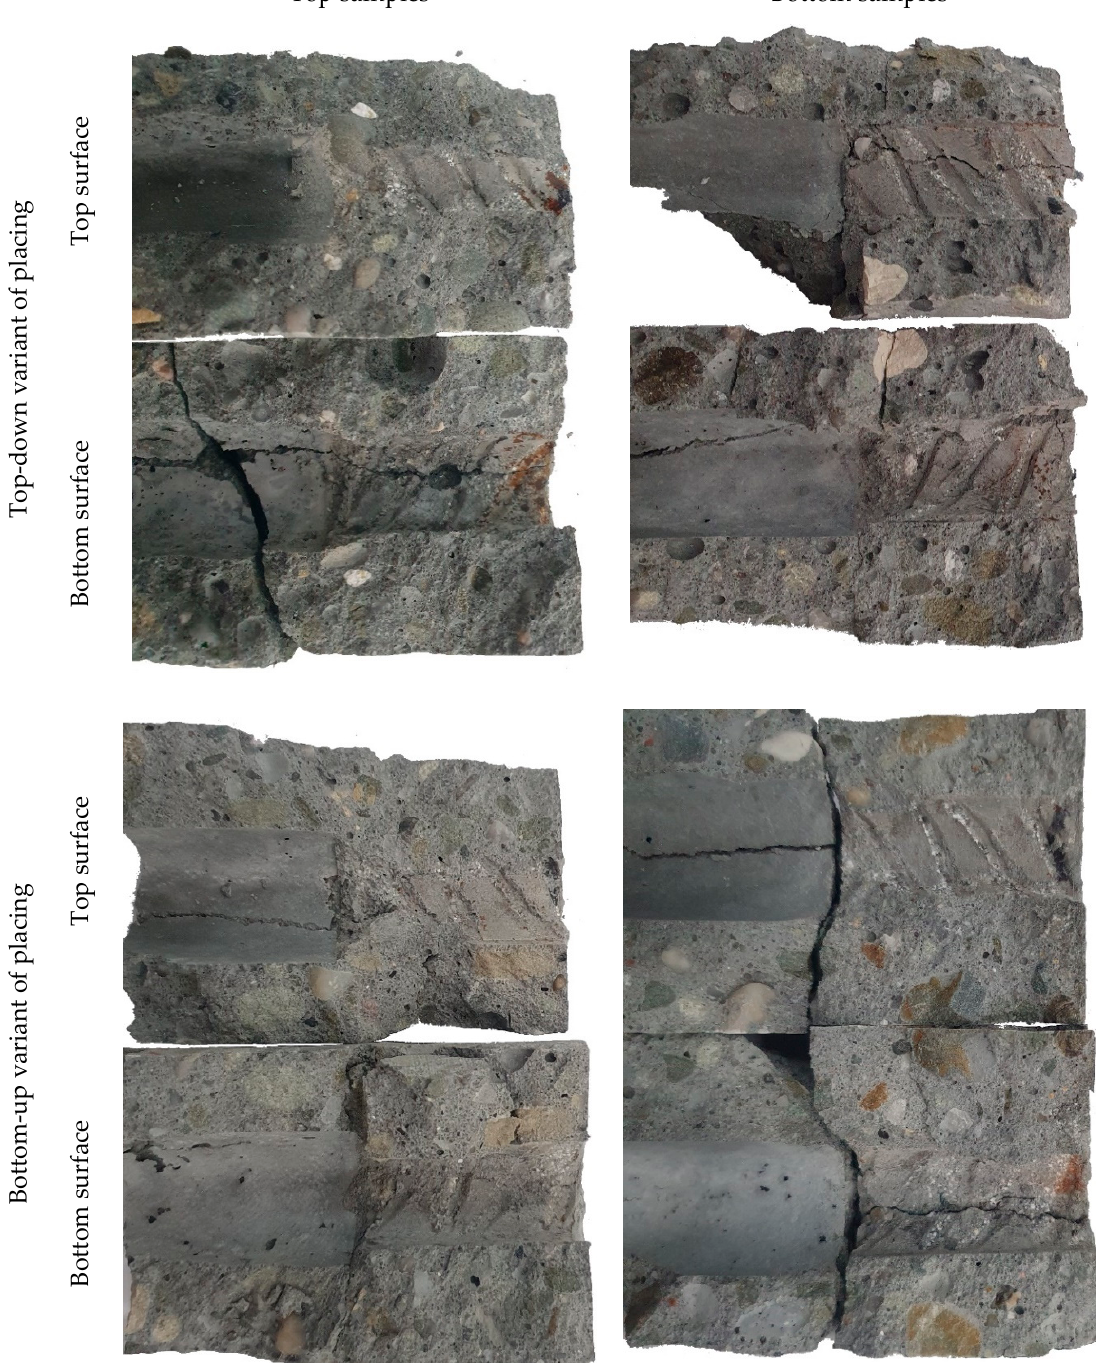
Figure 9. Views of SCC surface above and below rebar after pull-out